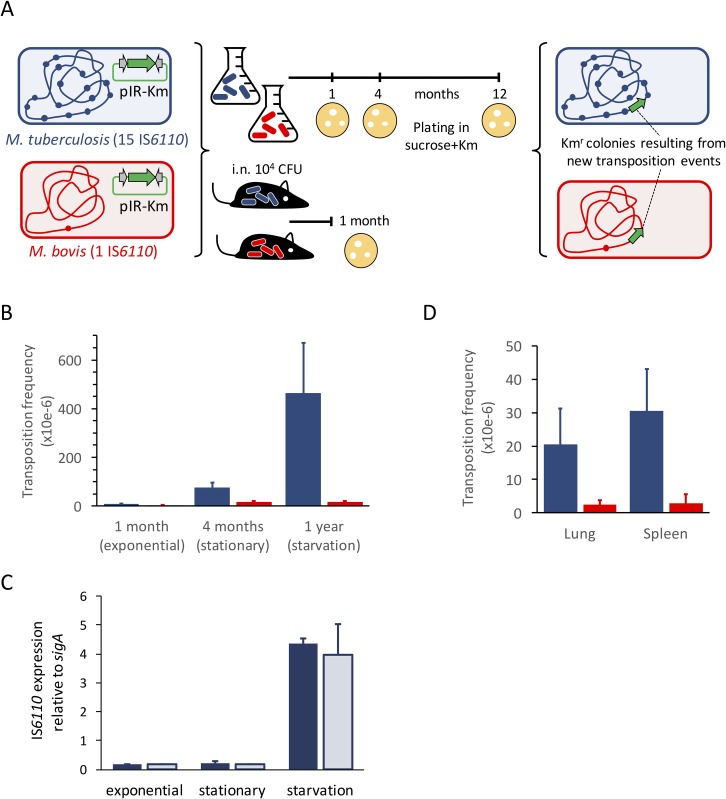
Transposition in the laboratory and in a mouse infection model using reference M. bovis and M. tuberculosis strains.(a) Experimental model to measure transposition rates in M. tuberculosis H37Rv (15 IS6110 copies) and M. bovis AF2122/97 (1 IS6110 copy). Both strains are transformed with pIR-Km and used to inoculate liquid media or to intranasally infect C57BL/6 mice. After the indicated time points aliquots are plated in kanamycin and sucrose containing plates to ensure pIR-km loss and to recover colonies resulting from transposition. (b) Transposition frequencies in laboratory medium in M. bovis and M. tuberculosis are indicated by red and blue columns respectively. Error bars indicate the standard deviation of the mean value from three independent cultures. Transposition preferentially occurs in M. tuberculosis after the stationary phase reaching it maximum in the starvation period. (c) Expression of M. tuberculosis IS6110 during exponential, stationary and starvation periods in vitro. Expression of ORF1 and ORF2 are indicated by dark and light blue columns respectively. Results are from three independent cultures. (d) Transposition frequencies during mouse infection with M. bovis or M. tuberculosis are indicated by red and blue columns respectively. Data from lung and spleen are shown and error bars indicate the standard deviation of the mean value from three independent mice. M. bovis does not exhibit increased transposition rates in vivo relative to liquid culture. Conversely M. tuberculosis show 10-fold higher transposition rates compared to exponential growth in vitro. In all cases, transposition frequencies were calculated relative to the total number of CFU in either cultures or mouse organs.